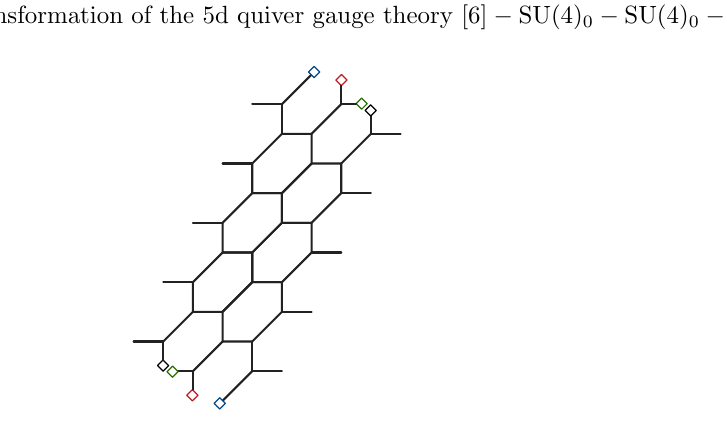
Figure 14 . Same theory with di(cid:11)erent mass